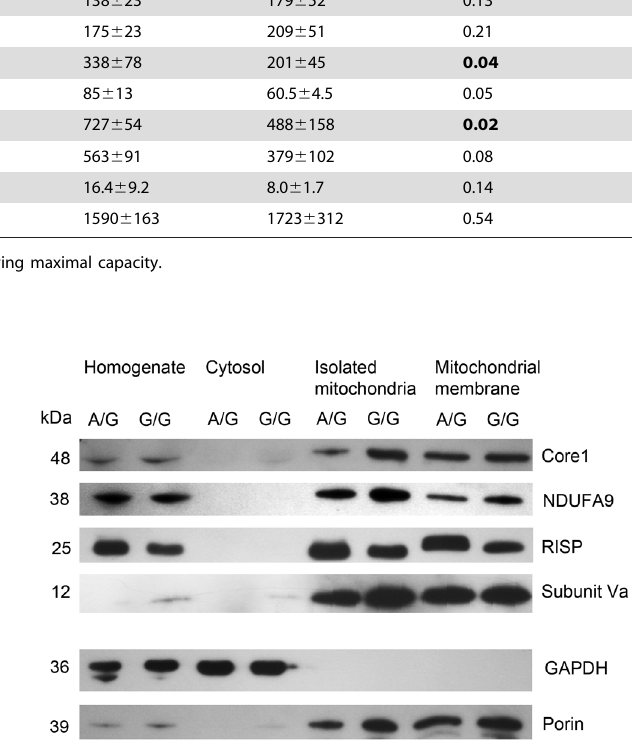
Figure 1. Mitochondria from Bcs1l G/G mice contain less mem- brane located RISP. Liver tissue from sick Bcs1l G/G (G/G) and control (A/G) mice aged P26 was homogenized and subsequently separated into cytosolic, mitochondrial and mitochondrial membrane fractions. These fractions were analyzed by SDS PAGE and Western blot detecting CIII subunits Core1 and RISP, CI subunit NDUFA9, and CIV subunit Va. Porin and Glyceraldehyde-3-phosphate dehydrogenase (GAPDH) were used as markers for mitochondrial membrane and cytosol, respectively, and as loading controls.